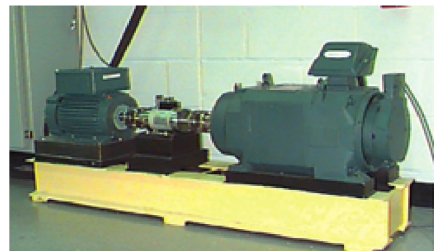
Figure 3: Motor driving mechanical system used by